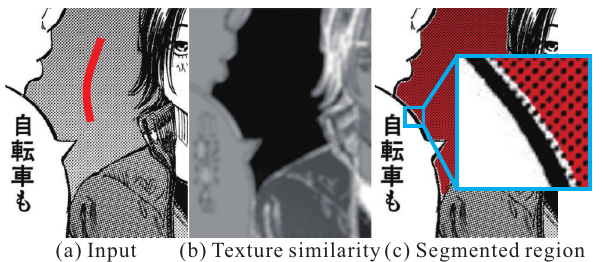
Fig. 3 Texture region segmentation based on Gabor features. Note that a precise boundary cannot be